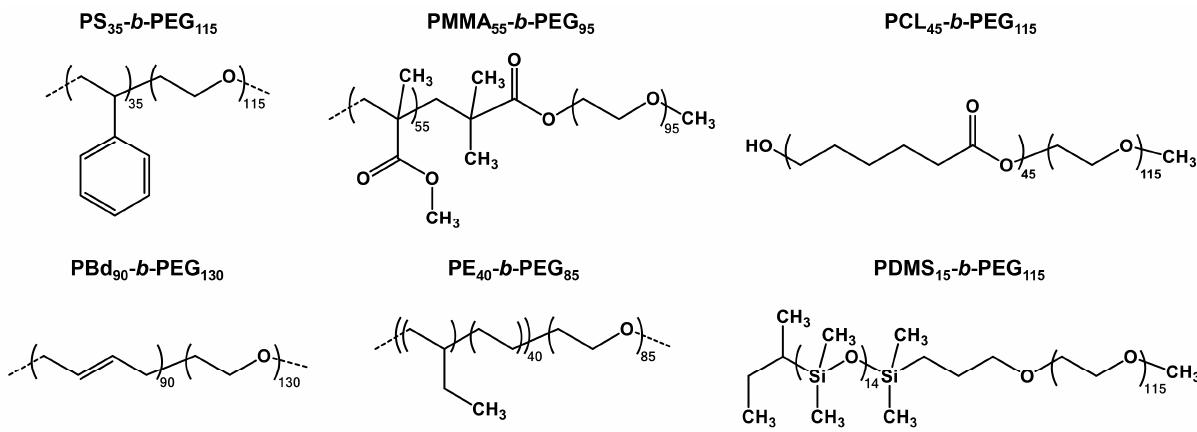
Scheme 1. Chemical structures of diblock copolymers used in the